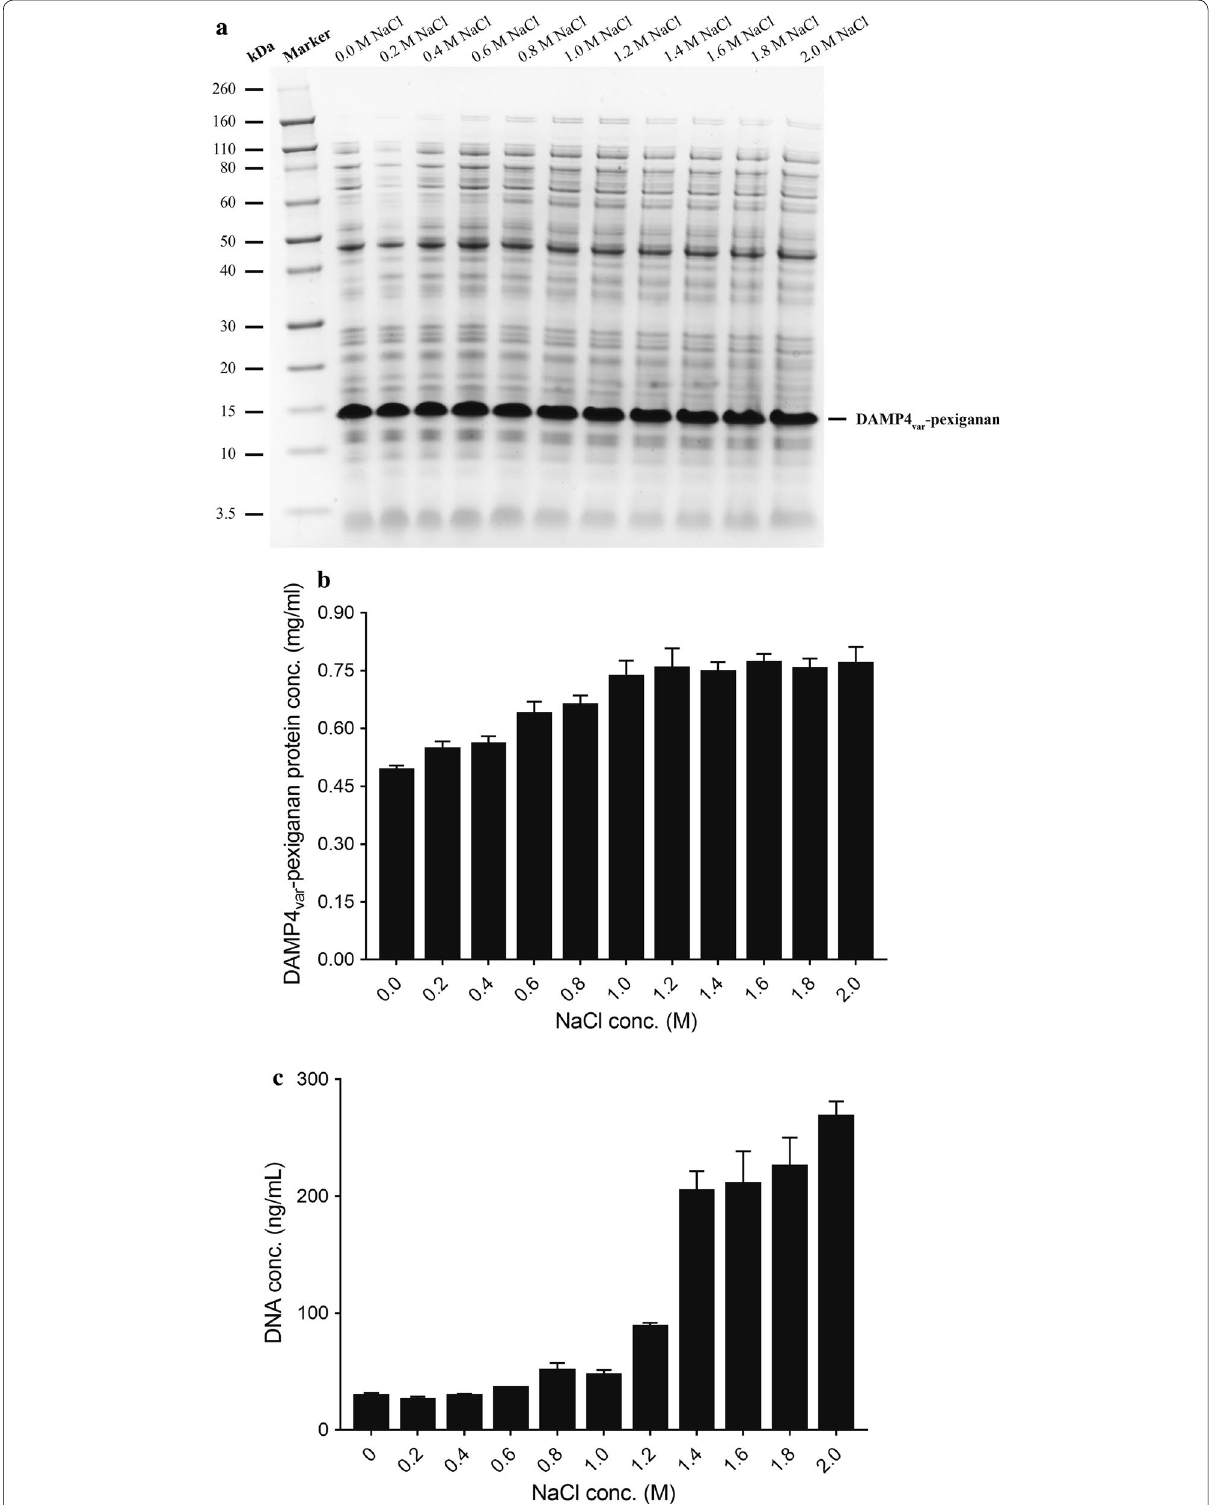
Fig. 1 Effect of NaCl concentrations (0–2 M) on the DNA precipitation using poly(ethyleneimine) (PEI) 0.5% (w/v) in Tris–HCl buffer (25 mM, pH 8). a SDS–PAGE analysis. Concentrations of ( b ) DAMP4 var ‑pexiganan protein and c DNA remaining in the solution after PEI